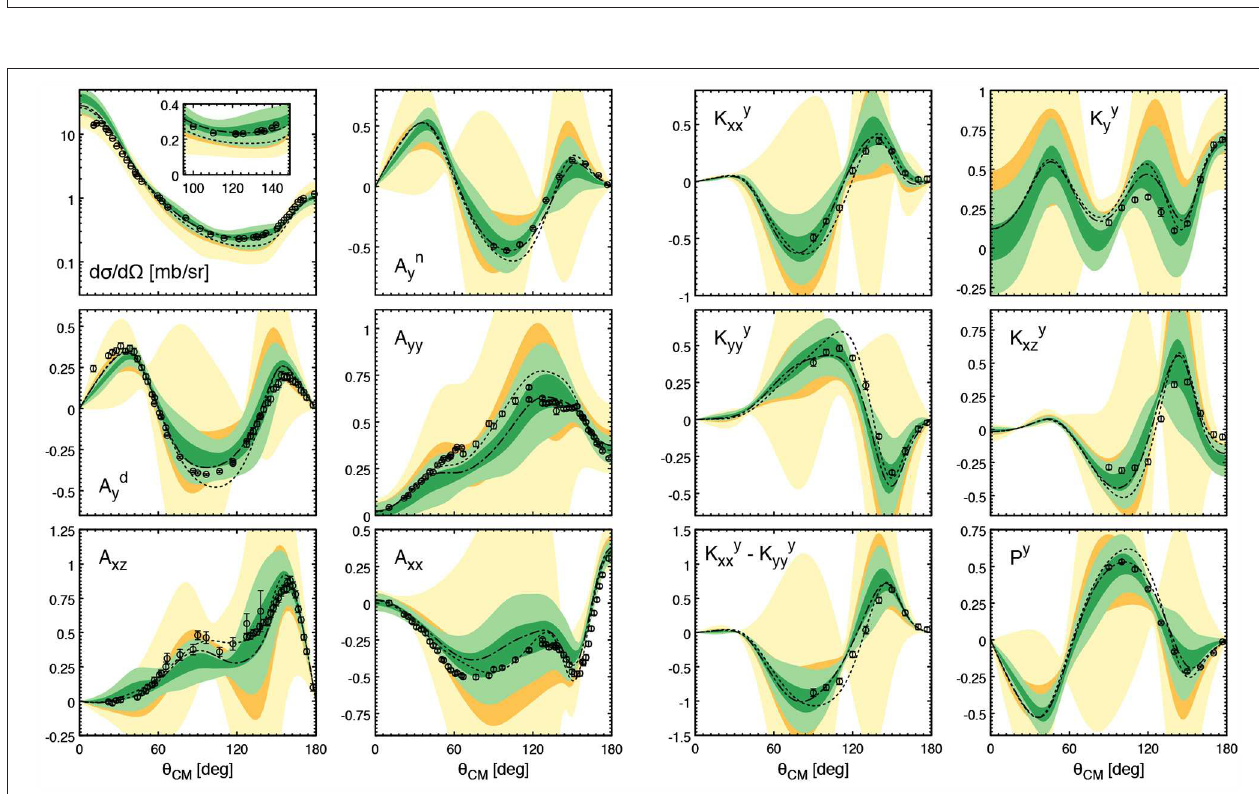
FIGURE 11 | Predictions for the differential cross section, nucleon and deuteron analyzing powers A n y and A d y , deuteron tensor analyzing powers A yy , A xz , A xx , polarization transfer coefficients K y Open circles are proton-deuteron data from Sekiguchi et al. [184]. The dotted (dashed-dotted) lines show the results based on the CD Bonn NN potential [146] (CD Bonn NN potential in combination with the Tucson-Melbourne 3NF [170]). All results are obtained using the N 2 LO SMS NN potential from Reinert et al. [17] in combination with the N 2 LO SMS 3NF for the momentum-space cutoff 3